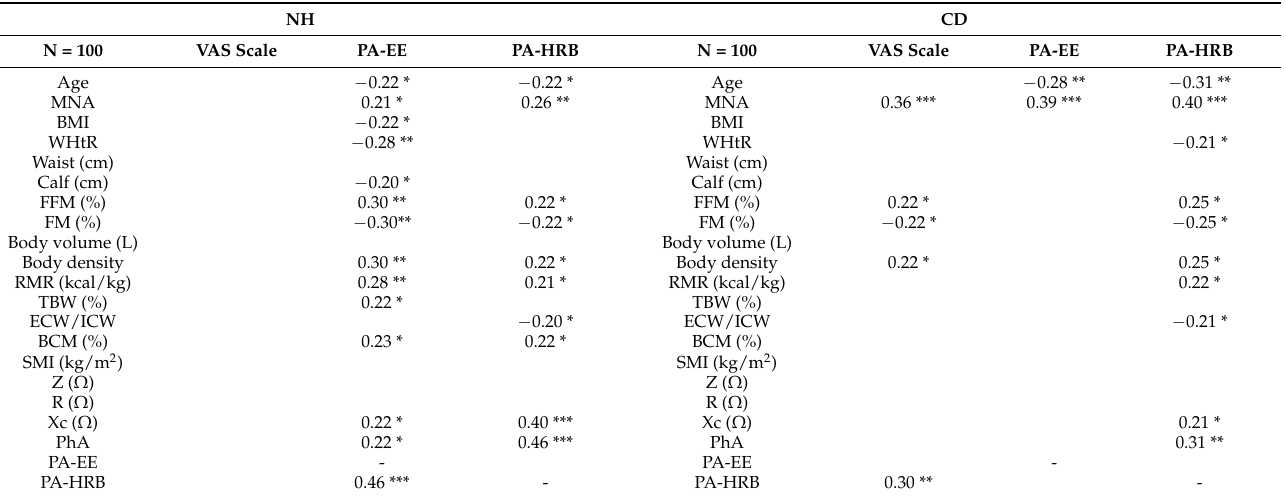
Table 3. Statistically significant correlations between VAS scale/PA and age/selected indicators of nutritional status in both